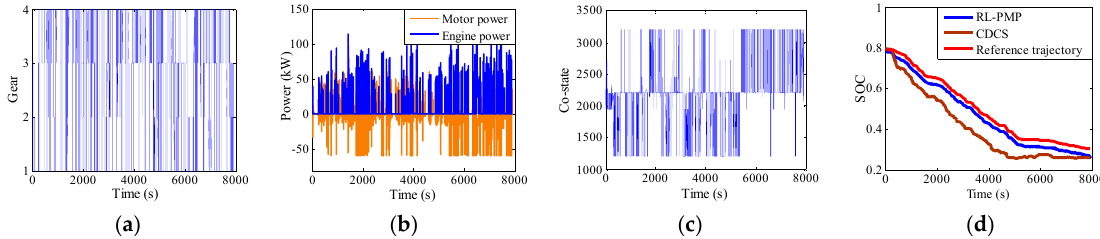
Figure 21. The HIL results of No.21. (a) denotes the gears, (b) denotes the powers of the motor and the engine, (c) denotes the co-state, and (d) denotes the SOC trajectories.